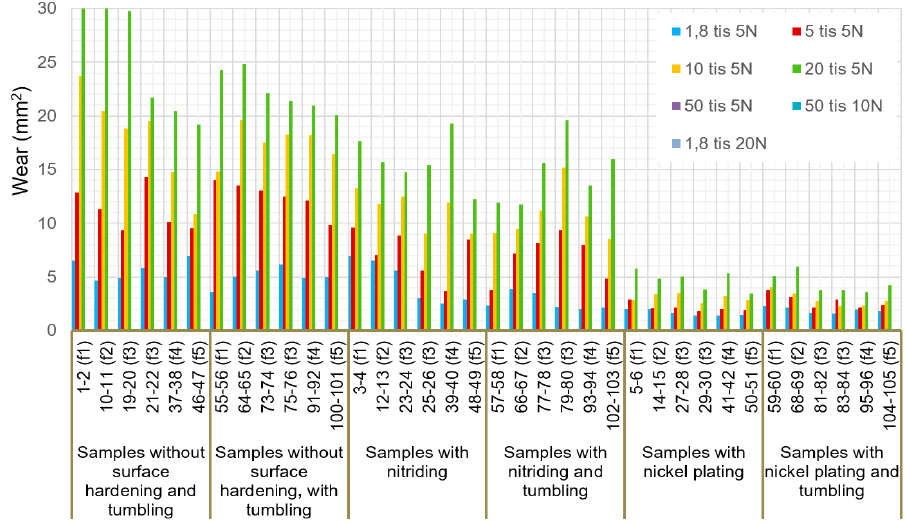
Figure 16. Graphs of all cylinders’ wears—measured on the tribometer.